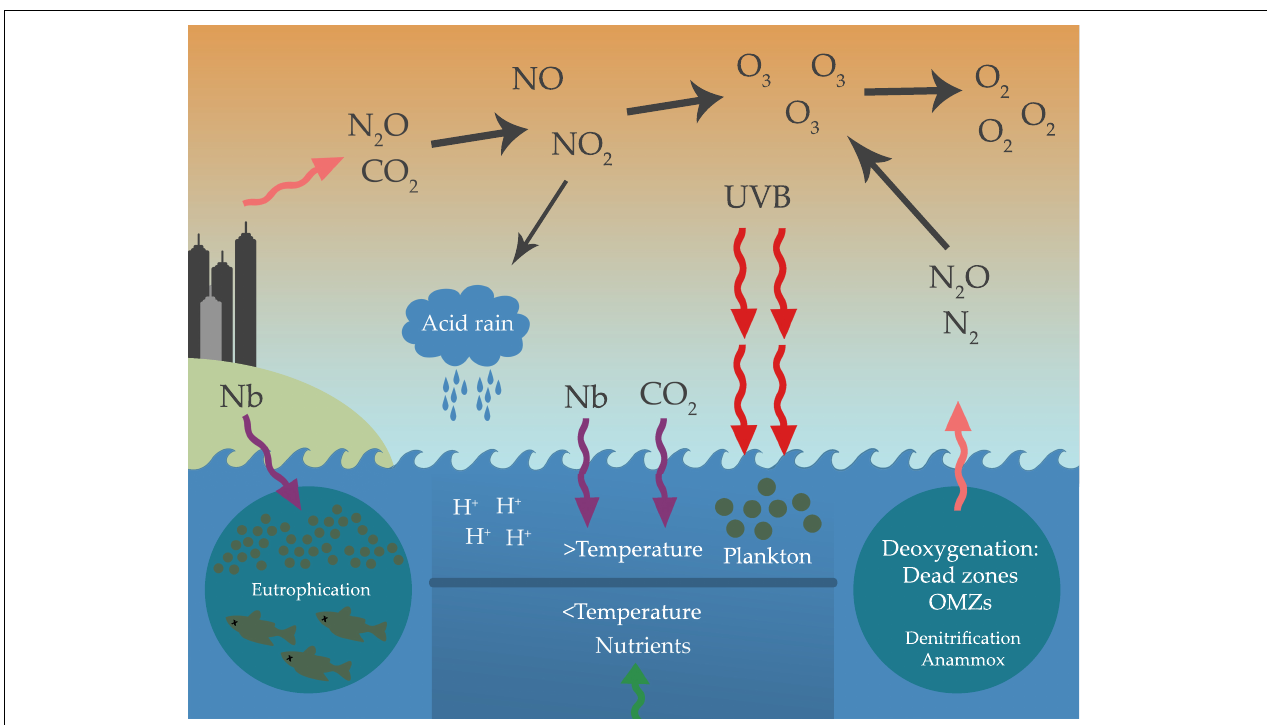
FIGURE 3 | Anthropogenic activities and their effects on the marine N cycling. Bioavailable N (Nb) is introduced into the marine ecosystems by runoff or atmospheric deposition, causing eutrophication, the formation of dead zones and the expansion of the ocean minimum zones (OMZs). The release of N oxides (N 2 O, NO) from anthropogenic activities and oxygen-depleted zones causes stratospheric ozone depletion leading to higher UVB exposition, which produces the damage of marine life, acid rain and ocean warming. Ocean warming causes water stratification, deoxygenation, and the formation of dead zones. Dead zones and OMZs are hotspots for anammox and denitrification, causing N loss (N 2 and N 2 O). Elevated atmospheric CO 2 acidifies seawater, decreasing pH-dependent N-cycling processes such as nitrification, and enhancing N 2